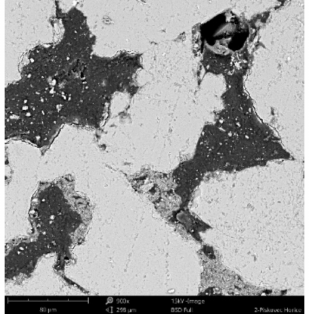
Figure 10. Phenom XL Desktop SEM